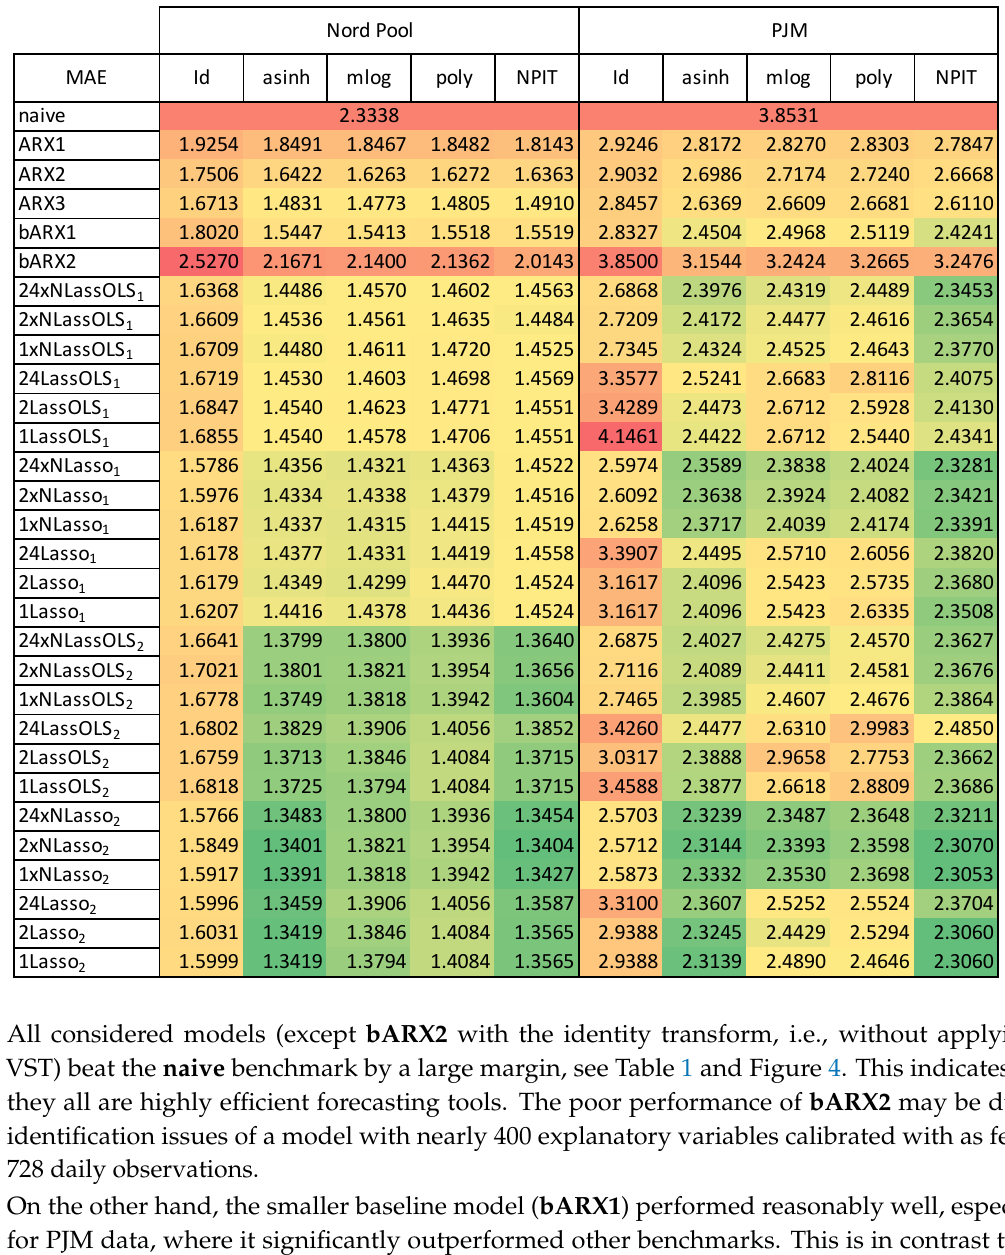
Table 1. Mean absolute errors (MAE) in the 631-day test period for 30 considered models (in rows), five variance stabilizing transformations (VSTs; in columns; the first ‘transformation’ is identity, Id ) and two markets (Nord Pool and PJM). The models include four benchmarks, two baseline models, 12 ∗ LassOLS 91 models and 12 ∗ Lasso 91 models. Note that all LASSO-type models use a 91-day validation i i window for selecting λ . A heat map is used to indicate better ( → green) and worse ( → red)